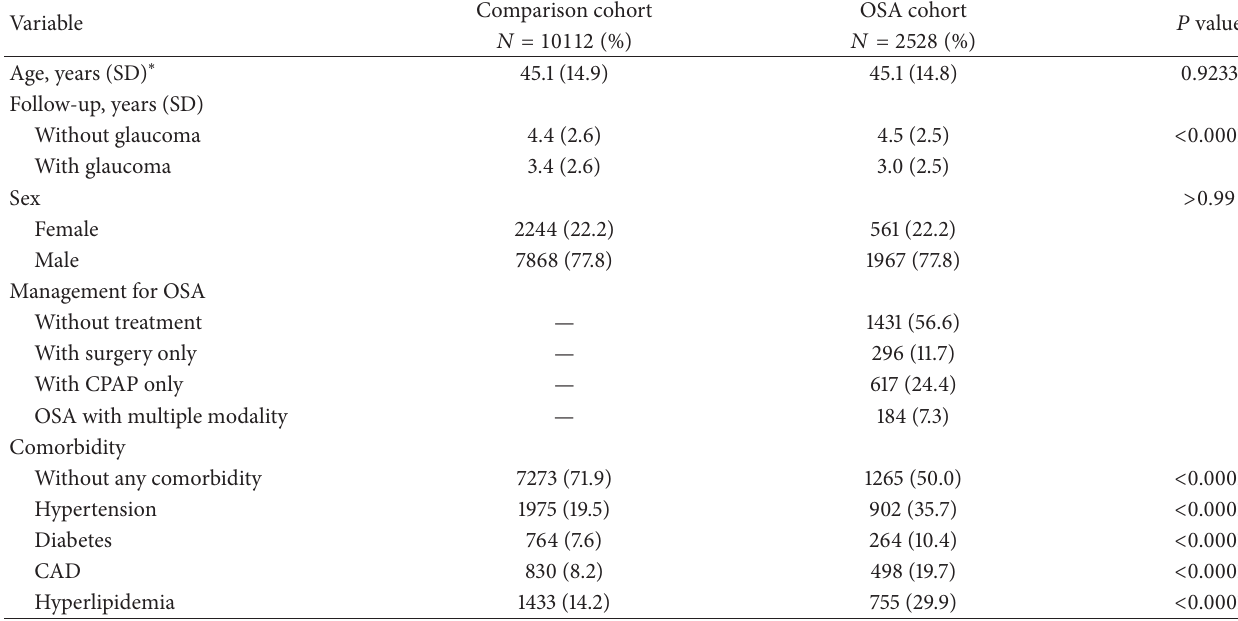
Table 1: The results of comparing baseline demographic status and comorbidity between comparison cohort and sleep apnea syndrome (OSA) cohort.